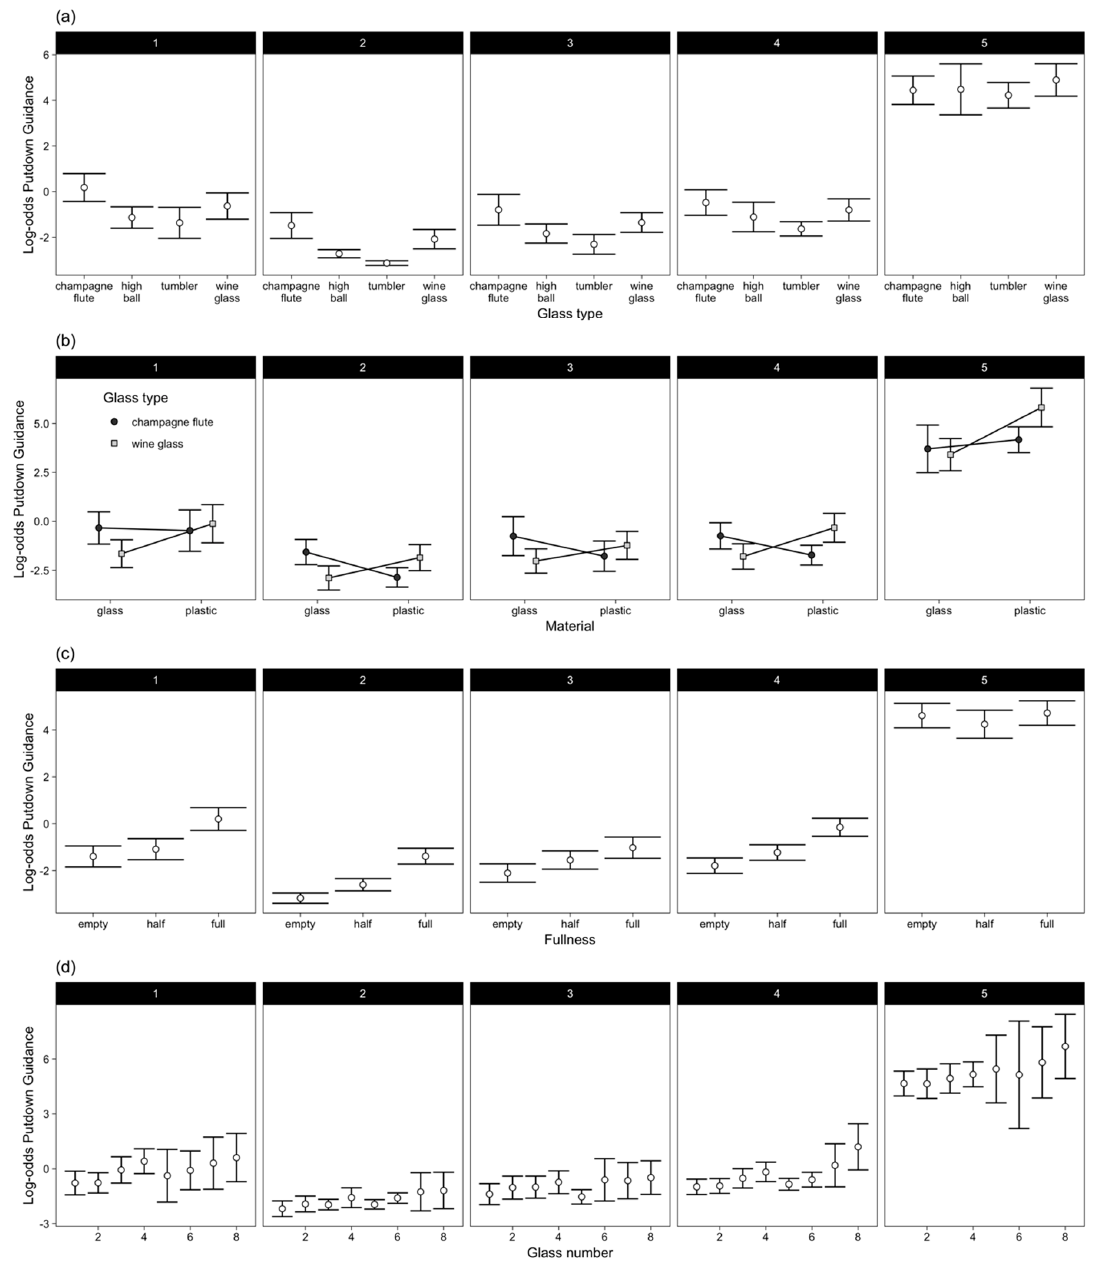
Figure A4. Log-odds plots of putdown 2 guidance (fully vs partially guided) with 95% CI showing the main effects of glass type (a), interaction between glass type and material (b), glass fullness (c) and glass number (d). Panels represent each participant.